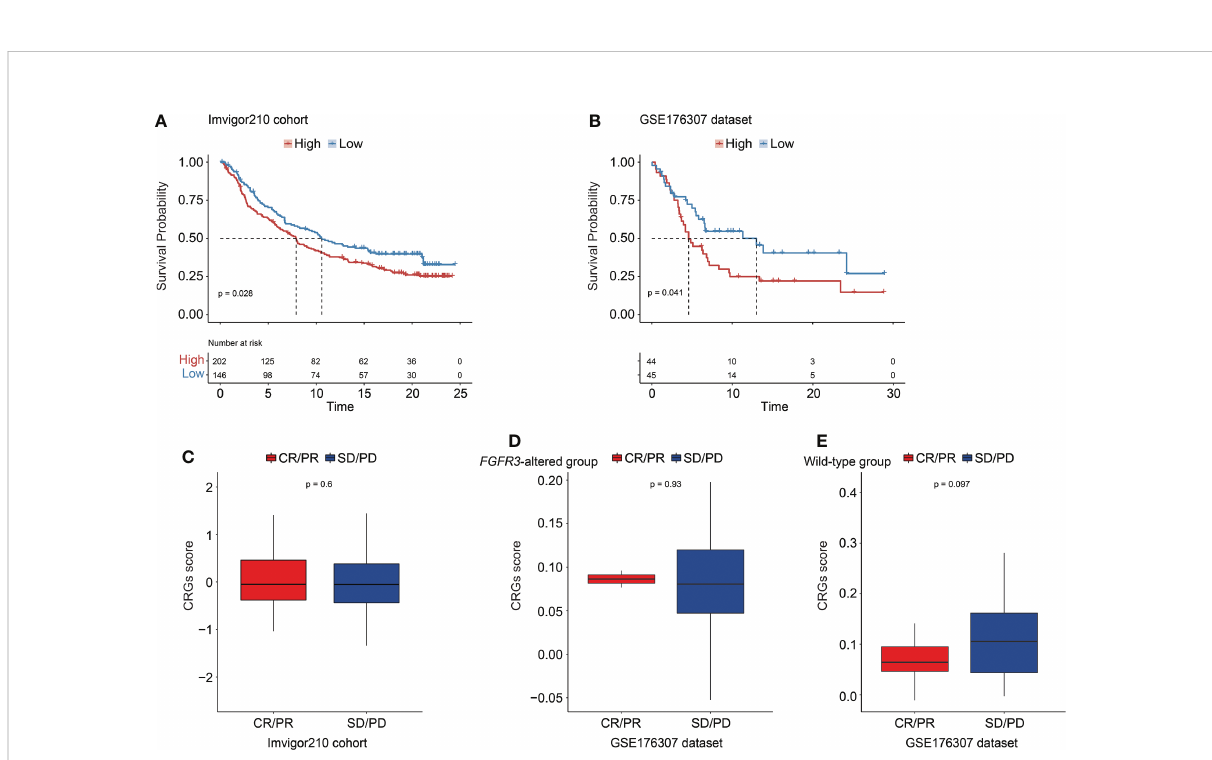
FIGURE 12 The predictive role of the CRG signature for the response of immunotherapy treatment in the IMvigor210 cohort and the GSE176307 dataset. Kaplan – Meier curve analysis to compare overall survival of patients between high-risk and low-risk groups from the IMvigor210 cohort (A) and the GSE176307 dataset (B) . Comparison of the CRG score between CR/PR and SD/PD groups in the IMvigor210 cohort (C) and in the groups of patients with altered FGFR3 (D) and with wild-type FGFR3 (E) from the GSE176307